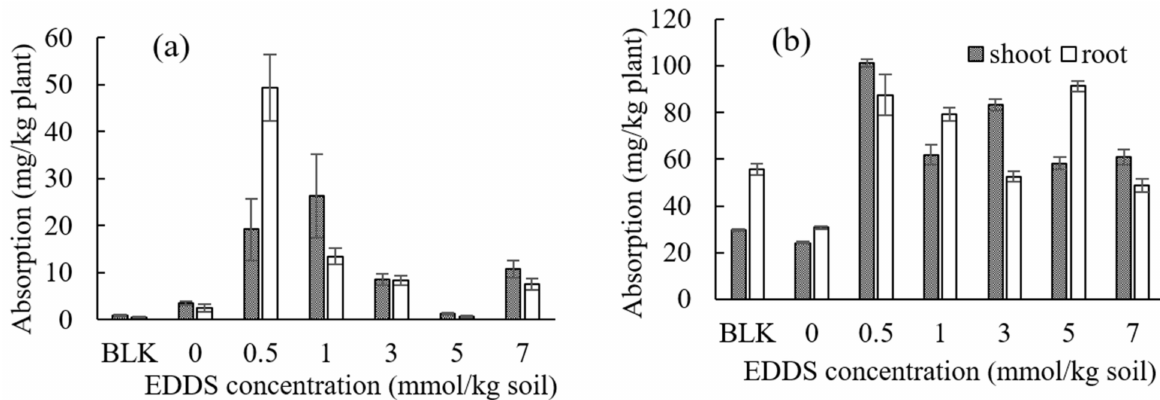
Figure 4. Effect of the EDDS concentration on the absorption of ( a ) Cd and ( b ) Zn by Taraxacum officinale under the presence of Al, Bi, Ni, and Pb. BLK (Blank) represents the pot for no addition of heavy metals (i.e., Al, Pb, Bi, and Ni) as well as no addition of EDDS (i.e., Pot No. 1 in Table